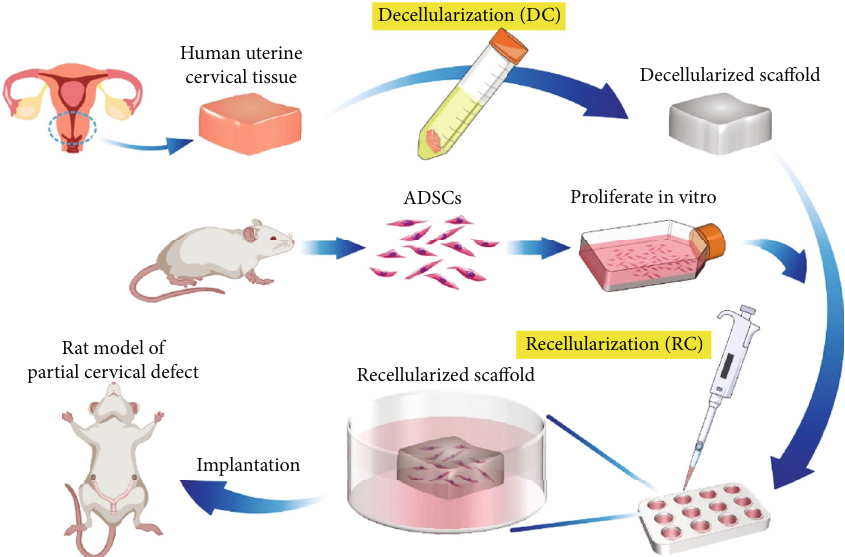
Figure 1: A brief schematic diagram of the experimental design. Human uterine cervical tissue was decellularized with detergents. ADSCs were isolated from rats, cultured, and then reseeded on the decellularized sca ff old. After coculture, recellularized sca ff old was implanted to a rat model of partial cervical